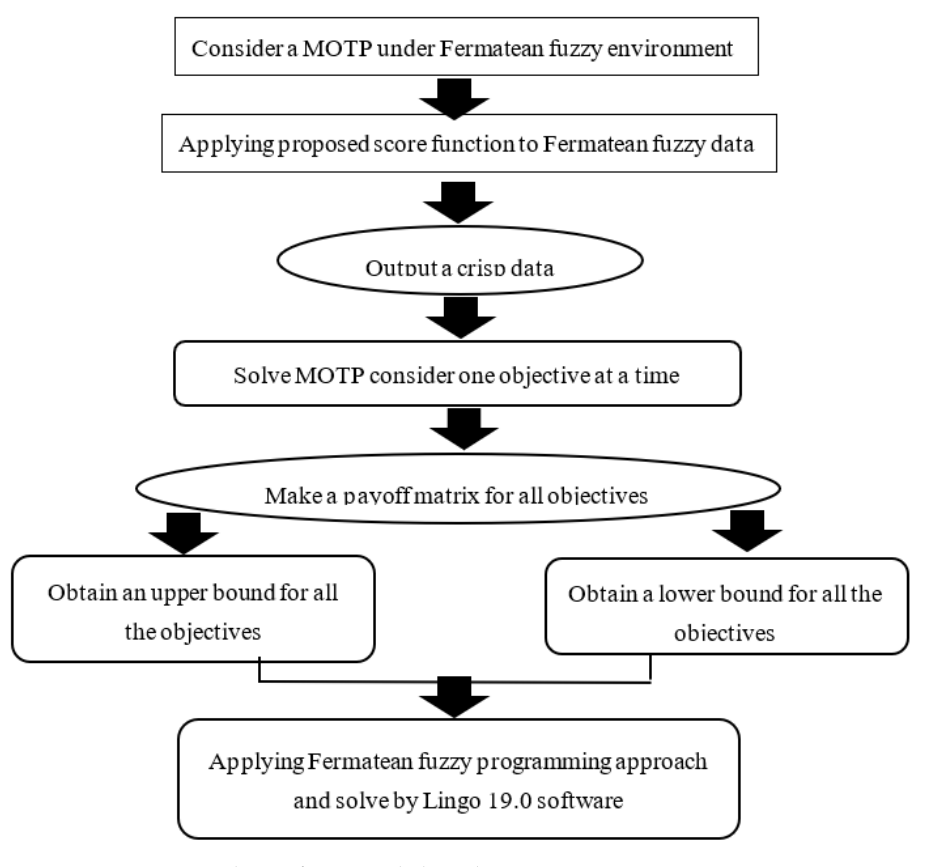
Figure 1. Structure outlines of proposed algorithm.